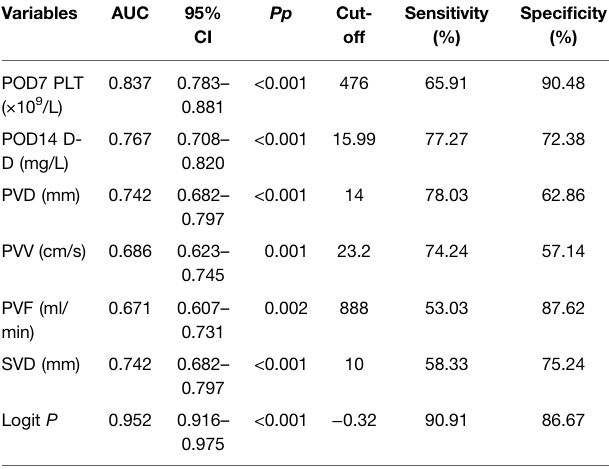
TABLE 5 | The area under the receiver operating characteristic curve of